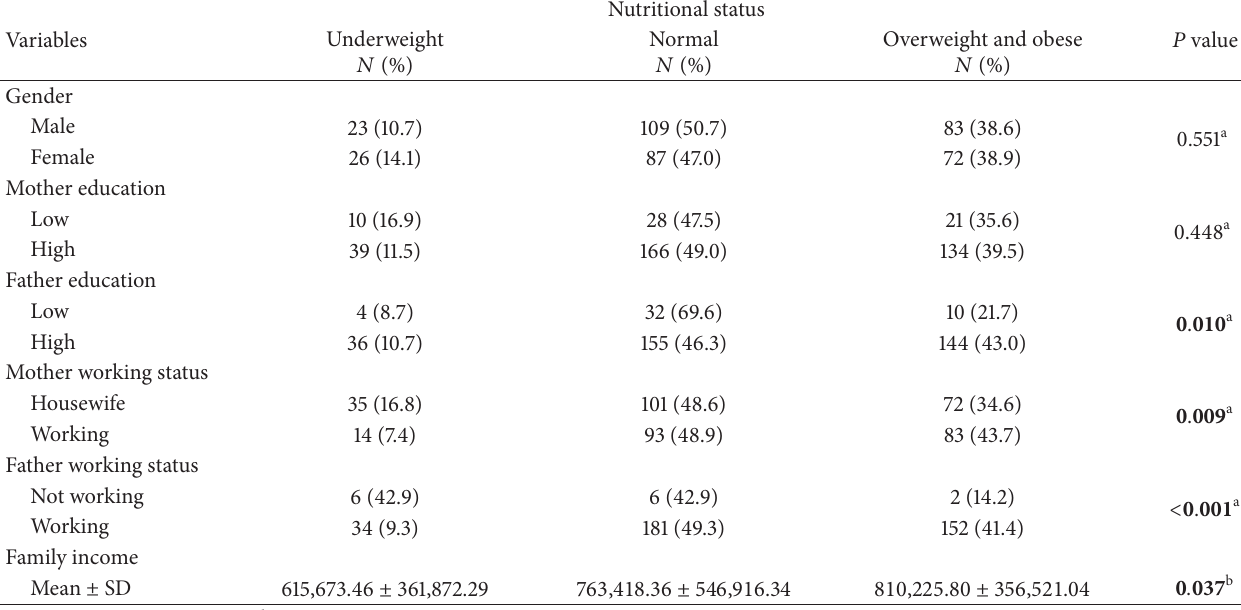
Table 1: Sociodemographic characteristics of